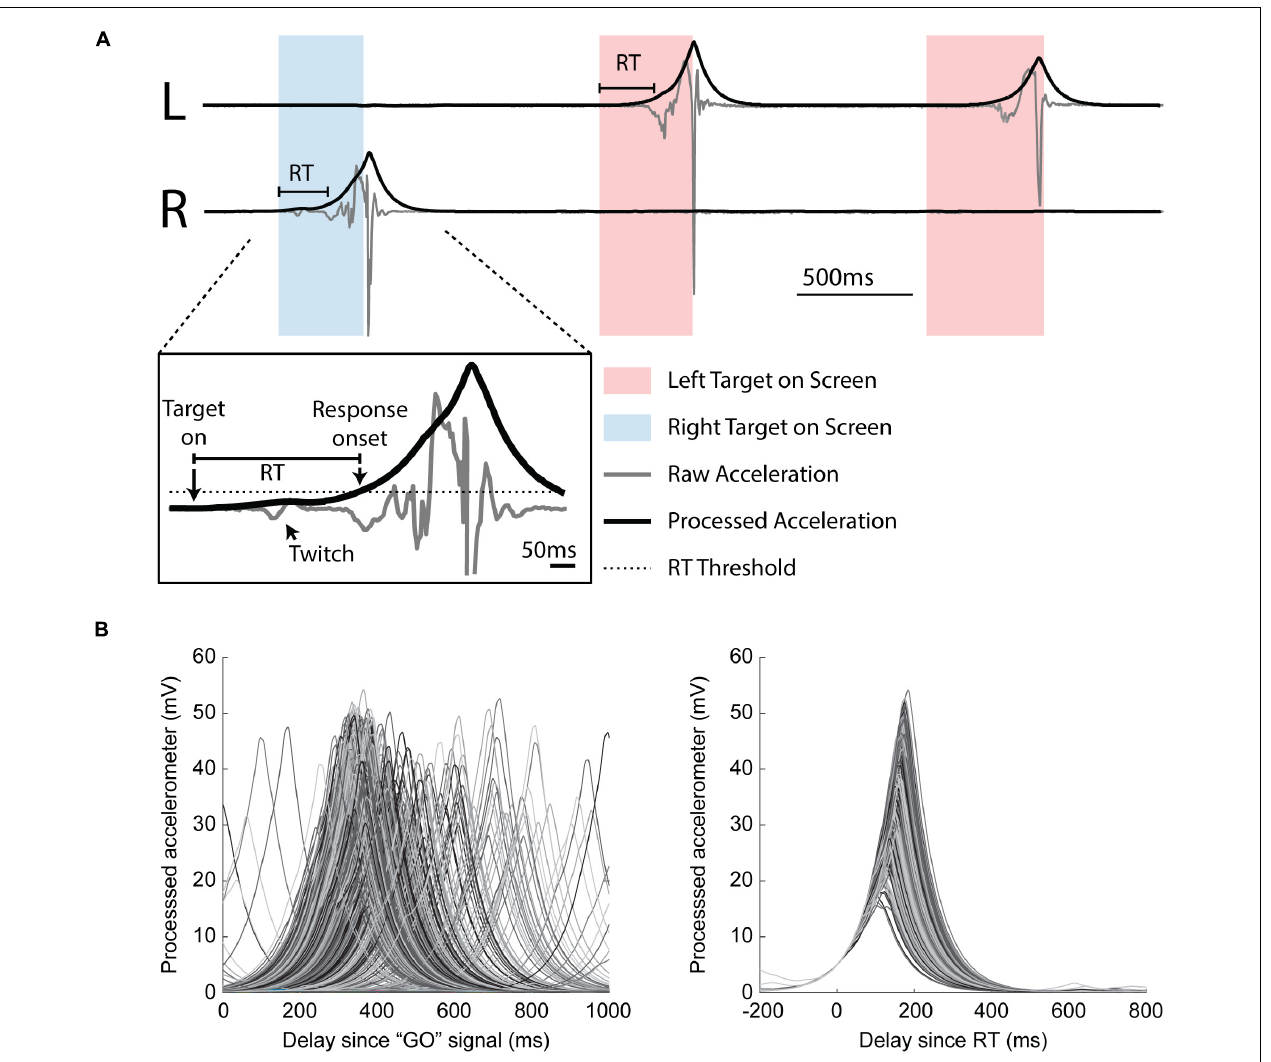
FIGURE 3 | Estimating reaction time. (A) Three example trials. Boxes indicate when the monkey was cued to move left (red box) or right (blue box). Responses were required to be unilateral. Inset: identification of reaction time (RT). Raw accelerometer signal (gray) is transformed into a processed signal (black) for RT estimation using a threshold (dotted line). Note the stimulus induced twitch lies below the threshold. (B) Aligned processed accelerometer traces. Left: aligned by GO signal. Right: aligned by calculated